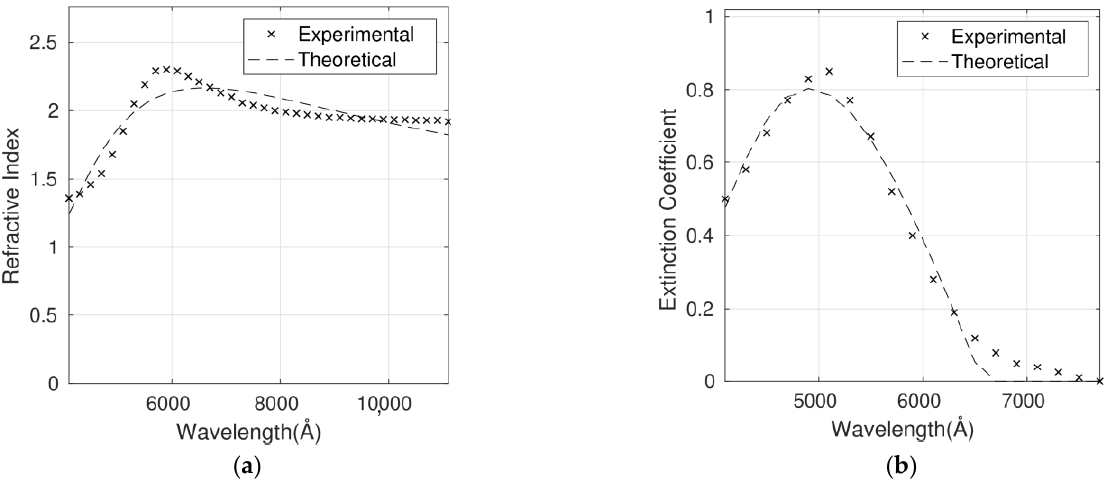
Figure 9. Refractive index ( a ) and extinction coefficient ( b ) fits to Cauchy´s equation for the P3HT/G (5 wt%) nanocomposite. Experimental data are adapted from Ref. [9] with permission from the American Institute of Physics, 2012.